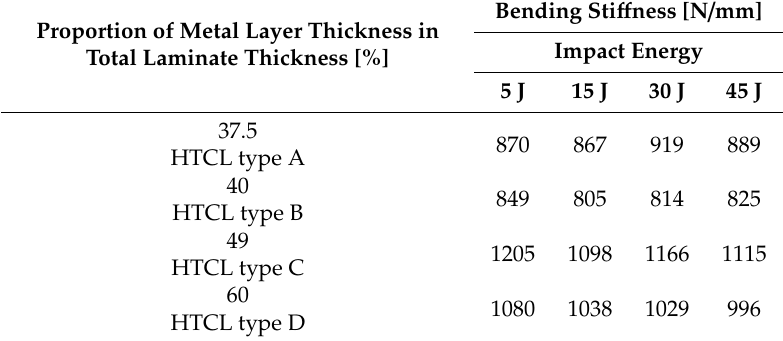
Table 3. Bending sti ff ness of tested HTCL with various layer